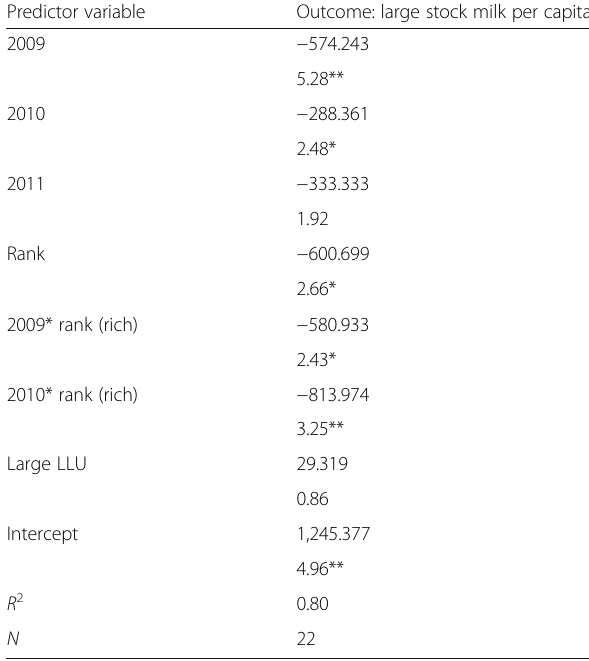
Table 6 Results of linear regression of small stock milk yield (per capita availability for human consumption), adjusted for lactating herd size and family size Predictor variable